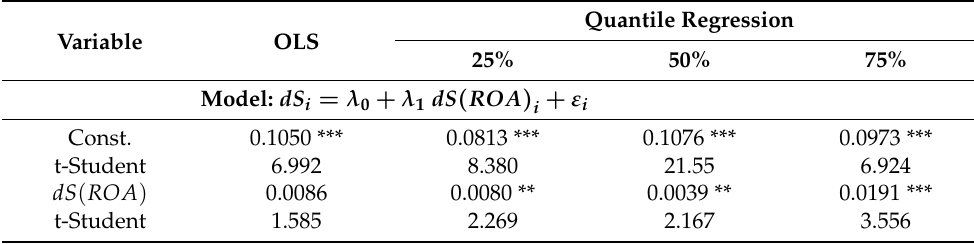
Table 9. Estimates of the relationship between the total market downside risk and total accounting downside risk.